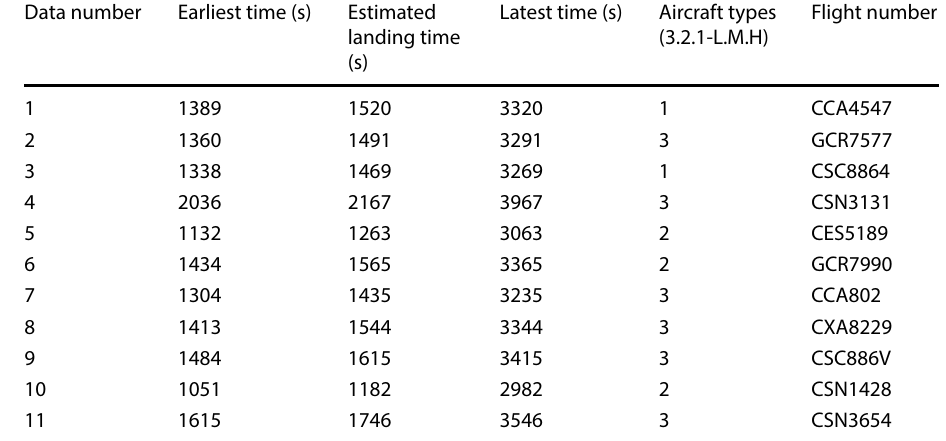
Table 1 The information of 11 flights between the outer ring and inner ring